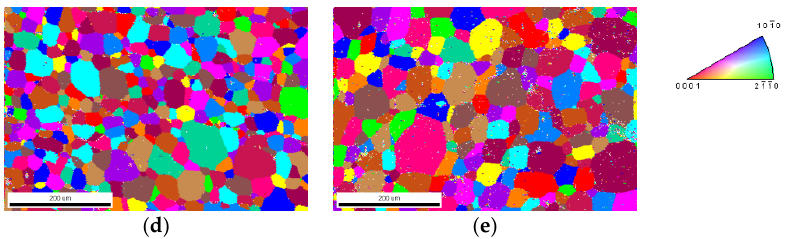
Figure 3. EBSD maps of commercially pure titanium showing the microstructure annealed at 800°C holding for ( a ) 0.5 h, ( b ) 1 h, ( c ) 2 h, ( d ) 4 h, and ( e ) 8 h. (Color online).